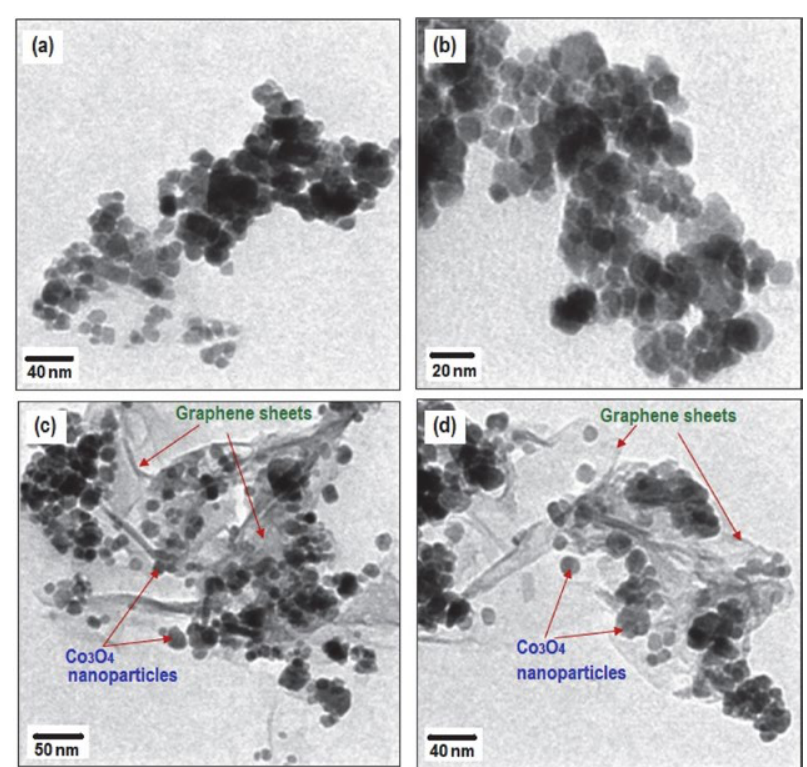
Figure 5. TEM images of (a,b) Co